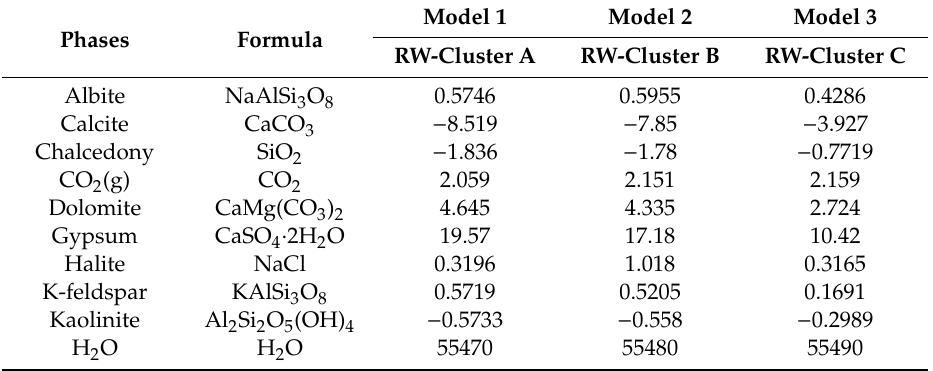
Table 5. Mineral transfers obtained by inverse modeling using PHREEQC (mmol / L).